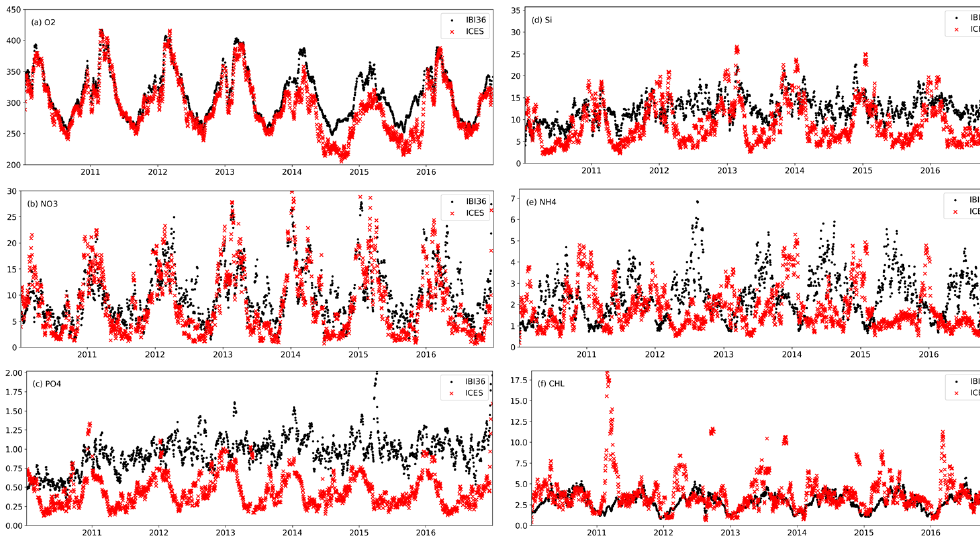
Figure 10. Time series of surface concentrations of (a) oxygen, (b) nitrate, (c) phosphate, (d) silicate, (e) ammonium and (f) Chl a from ICES (red) and IBI36 (black). Oxygen and nutrients are expressed in µmolL − 1 and Chl a in mgChlm − 3 . Daily averaged IBI36 outputs and ICES data are collocated in space and time between 2010 and 2016. Match-ups are averaged between 0 and 10m depth, and averaged daily. Time series are smoothed using a 10d